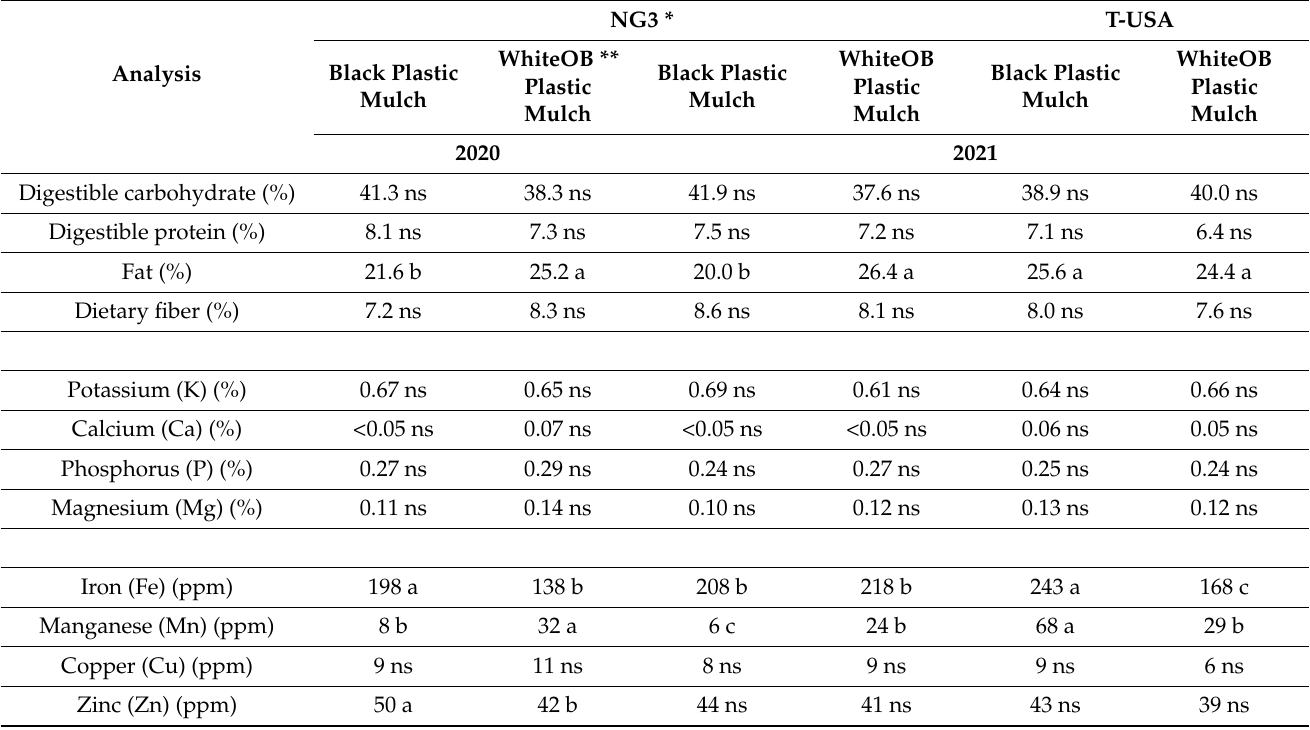
Table 6. Proximate and elemental analyses for NG3 and T-USA tigernut selections harvested at SPC-F in 2020 and